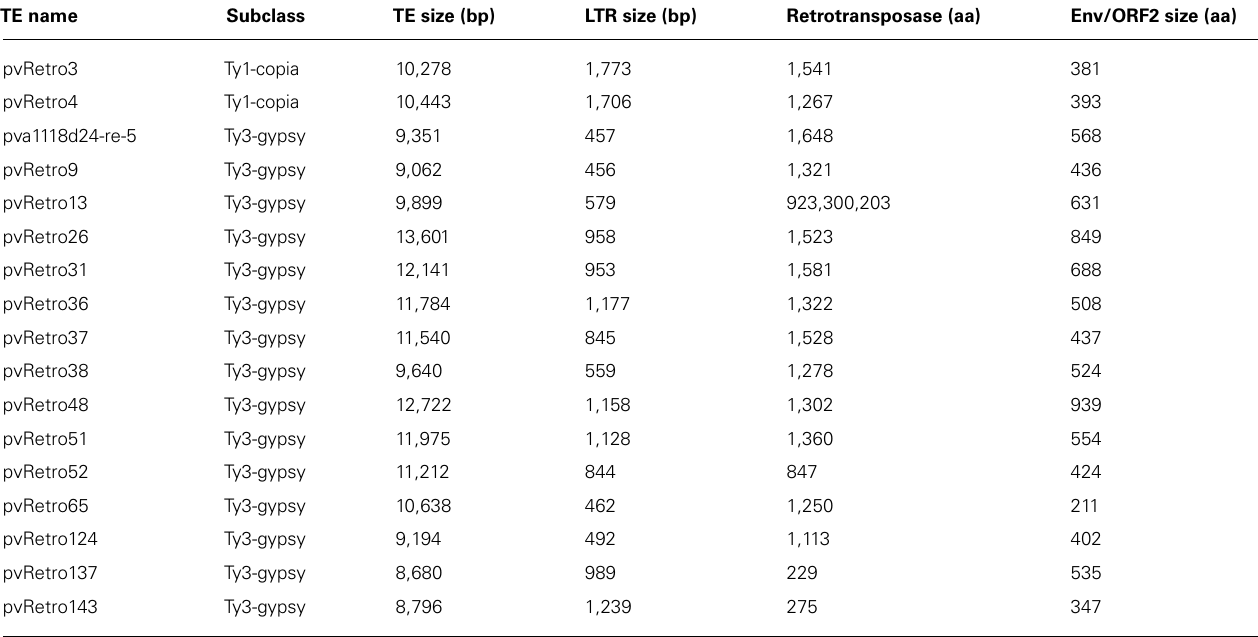
Table 2 | Common bean LTR retrotransposons with the envelope-like protein or an additional open reading frame